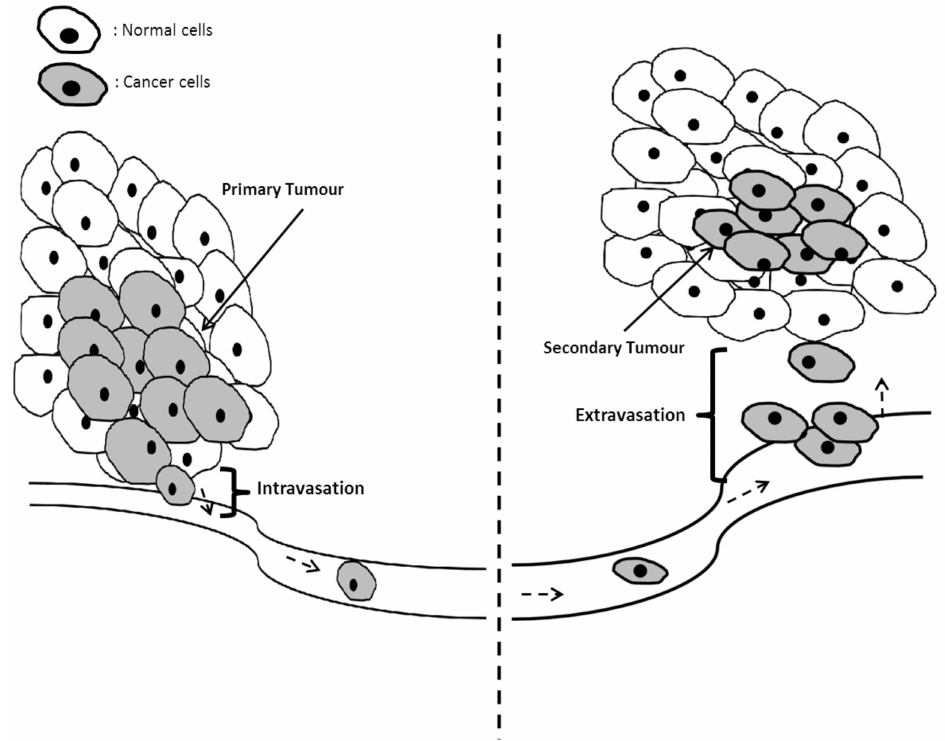
Figure 8. A brief overview of cancer metastasis. Cancer cells loses their adhering factors, leading to intravasation, a process whereby the cancer cells detach from the primary tumor site and invade the circulatory system. Once they are in the circulatory system, cancer cells will be disseminated throughout the body, followed by extravasation, where the cancer escapes the circulatory system and forms a secondary